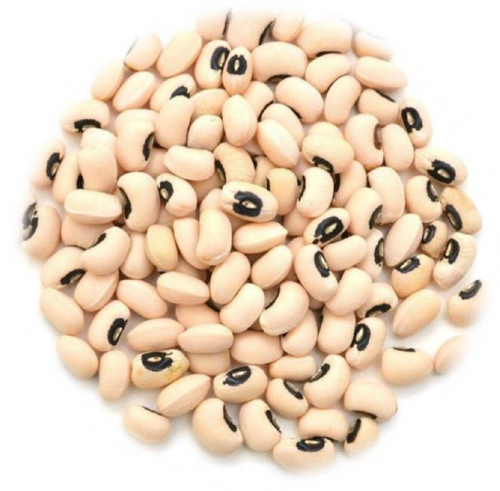
Fig. 25 Seeds of Vigna unguiculate as